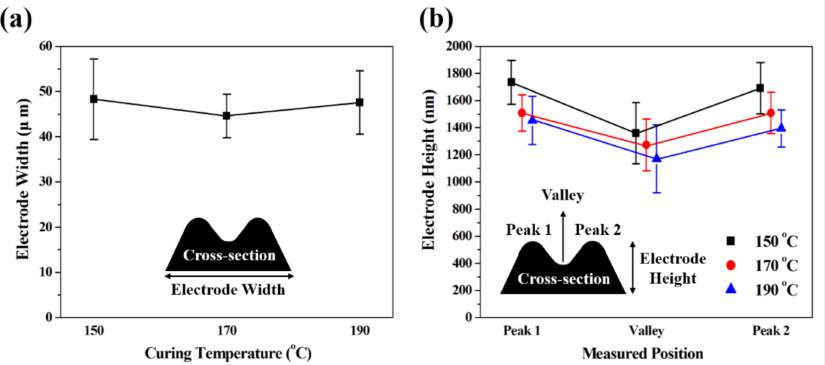
Figure 3. Surface profile measurement of the silver electrode fabricated at di ff erent curing temperatures; ( a ) width and ( b ) height of the